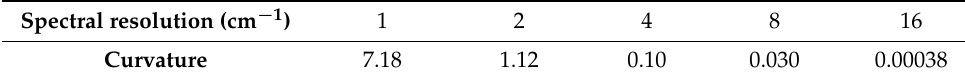
Table 3. The error of the synthetic background spectrum of C 3 H 8 .